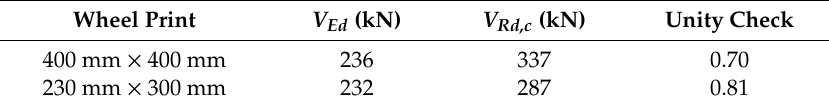
Table 4. Overview of the resulting Unity Checks according to the